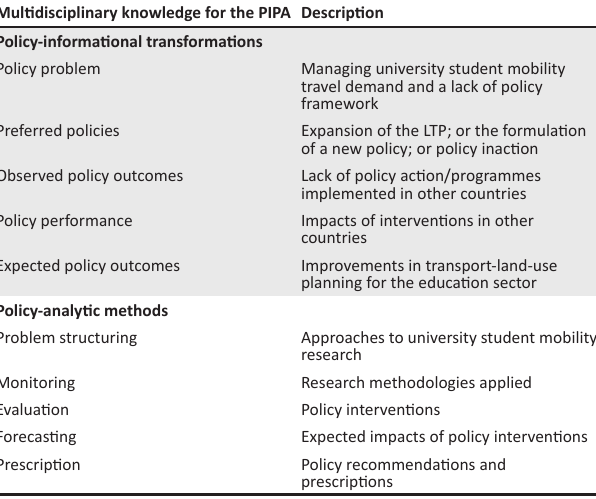
TABLE 2: Informational components and transformations for university student mobility. Multidisciplinary knowledge for the PIPA Description